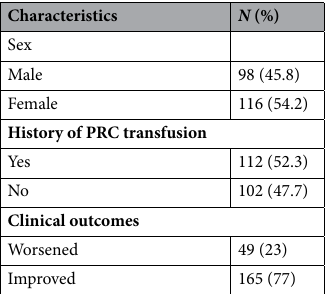
Table 1. Baseline characteristics of neonates with NEC in our institution. NEC necrotizing enterocolitis, PRC packed red cell.